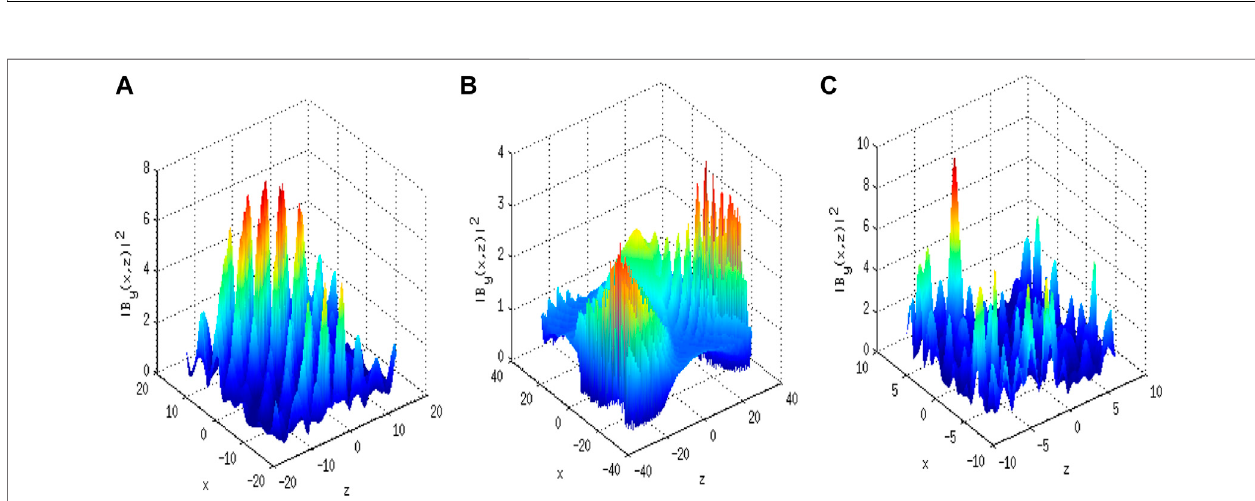
FIGURE 7 | Normalized magnetic fi eld intensity of wave | B 2 y | / B 2 n in a normalized x – z plane ( x normalized with x n (cid:2) ρ s and z normalized by z n (cid:2) 2/ k 0 z ) with IC-2 for (A) α x , α z (cid:2) 0 . 2, (B) α x , α z (cid:2) 0 . 1, and (C) α x , α z (cid:2) 0 . 4. “ Reproduced from [(Gaur and Sharma, 2015), J. Geophys. Res. Space Physics, 120, 2,397 – 2,408, doi:10.1002/ 2014JA020771], with the permission of AGU Publishing.